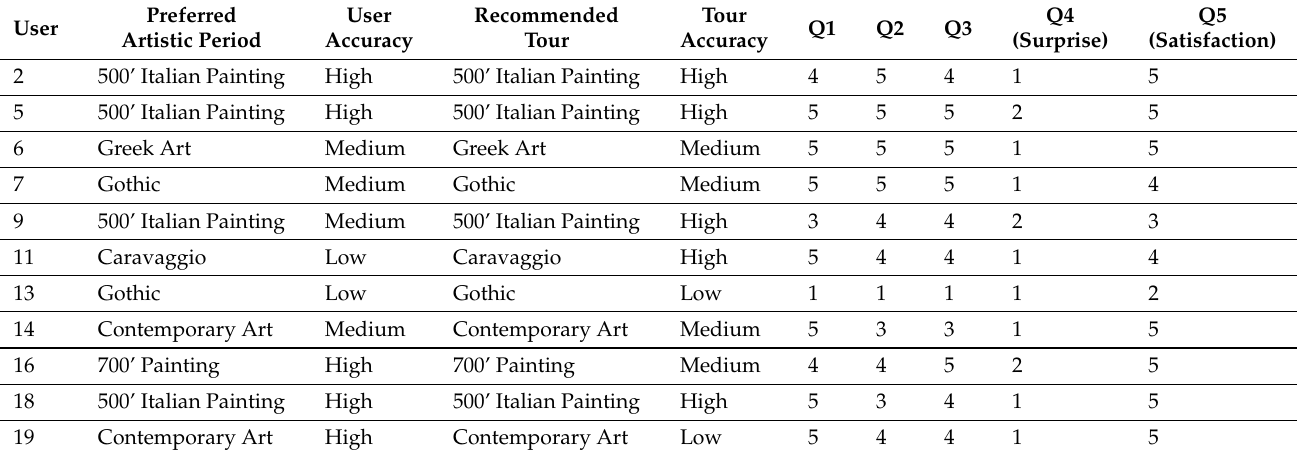
Table 1. The table summarizes the answers provided by the users to the questions in the survey after the robot provided literal help to the user. The robot recommended a tour corresponding to the artistic period the user indicated as preferred in the history of art.